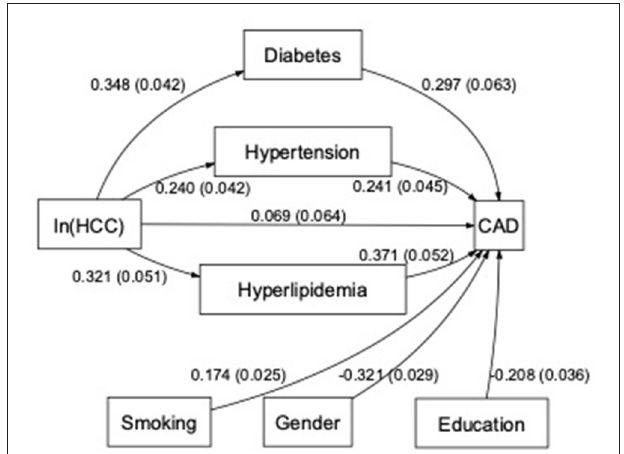
FIGURE 3 | Path diagram over the associations between the HCC, CAD, and standard modifiable cardiovascular risk factors. Boxes represent included variables in the path model and arrows the estimated associations (with the SE in parentheses) between variables in the path model. The arrow from logarithmized HCC [ln(HCC)] to CAD represents the direct association and the others represent the indirect associations. Smoking, gender with male as reference, and education with elementary school as reference were included as confounders in the